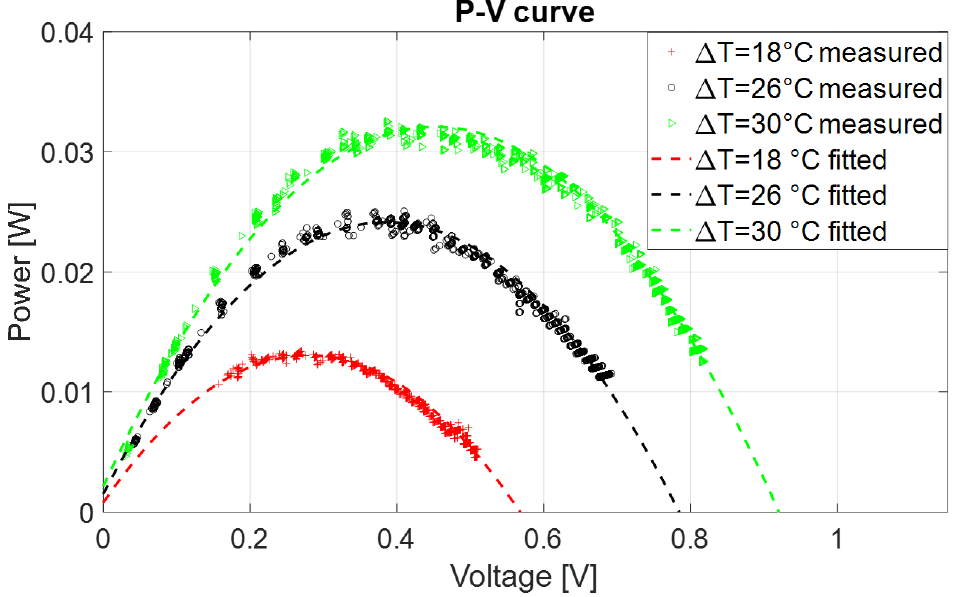
Figure 5. P-V characteristic curve measured (scatter plots) and fitted (dashed lines) at three tempera- ture gradients: ∆ T = 18 °C (red plots), ∆ T = 26 °C (black plots) and ∆ T = 30 °C (green